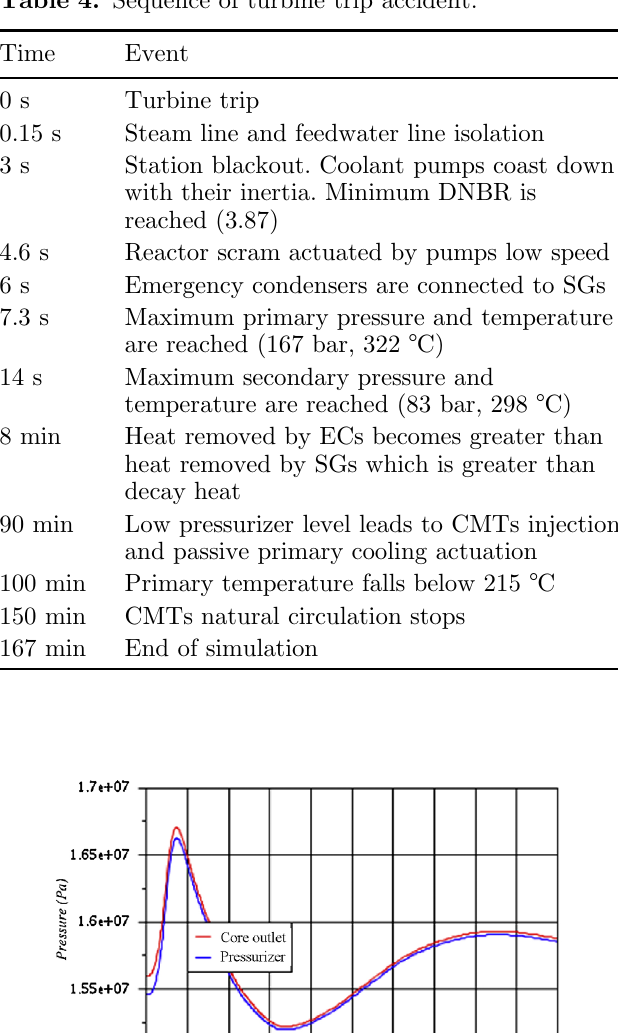
Table 4. Sequence of turbine trip accident.